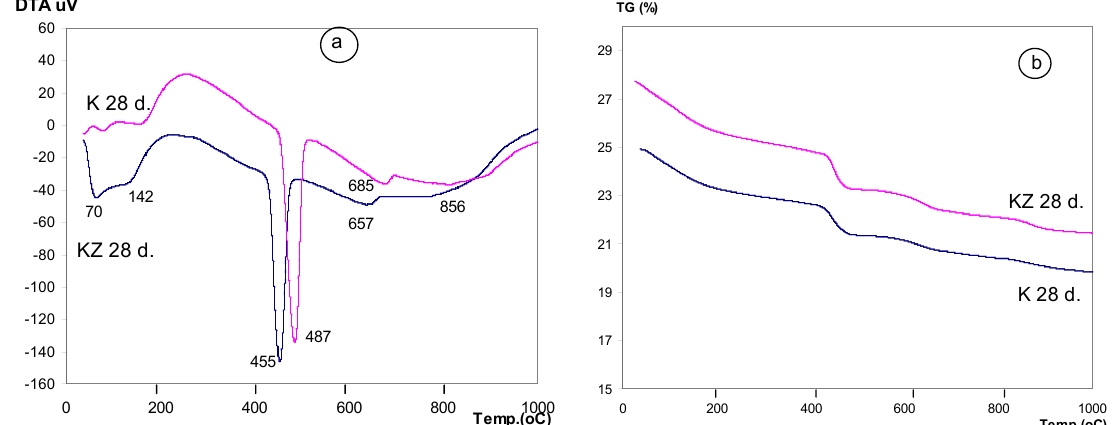
Figure 9. DTA (a) and TG (b) curves of K and KZ pastes hydrated 28